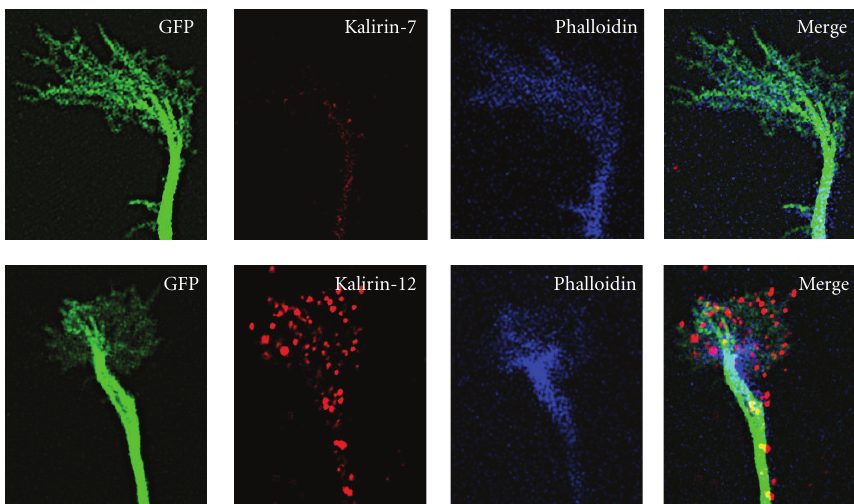
Figure 2: Kalirin-12, not Kalirin-7, is localized to the growth cone of hippocampal neurons. Primary cultures of hippocampal neurons prepared at embryonic day 20 (E20) were transfected with a vector encoding GFP on the day of culture preparation as described [19]. On day 3 after transfection, cultures were fixed for staining of filamentous actin with Alexa Fluor 633 Phalloidin (Life Technologies) and endogenous Kalirin-7 or Kalirin-12 with isoform-specific rabbit antibodies. Rabbit antibodies were visualized using Cy3 donkey anti-rabbit IgG (The Jackson Laboratory). Images were collected with a Zeiss confocal microscope